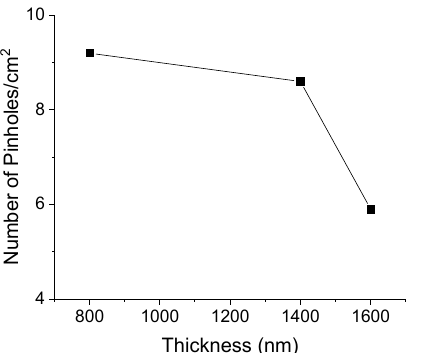
Figure 12. Evolution of the pinholes defect density with the Cr films thickness (PCB).